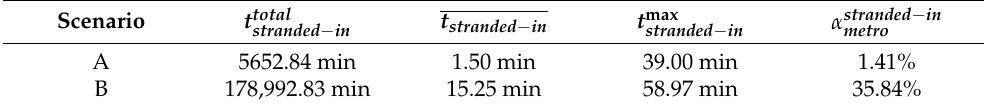
Table 9. Estimation results of stranded time and stranded rail passenger flow.